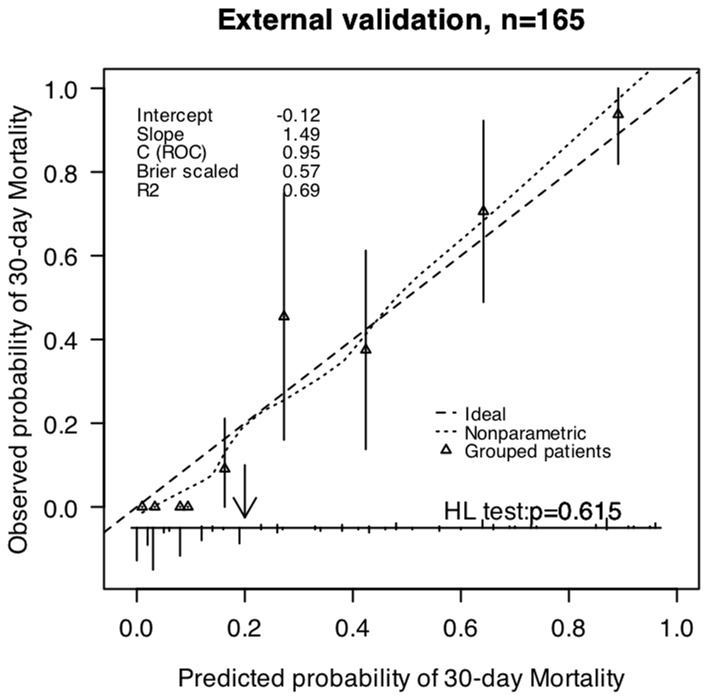
Validation of the prognostic models for 30-day mortality in validation patients (n = 165).The smooth dash curves reflect the relation between observed probability of mortality and predicted probability of mortality. The triangles indicate the observed frequencies by deciles of predicted probability.